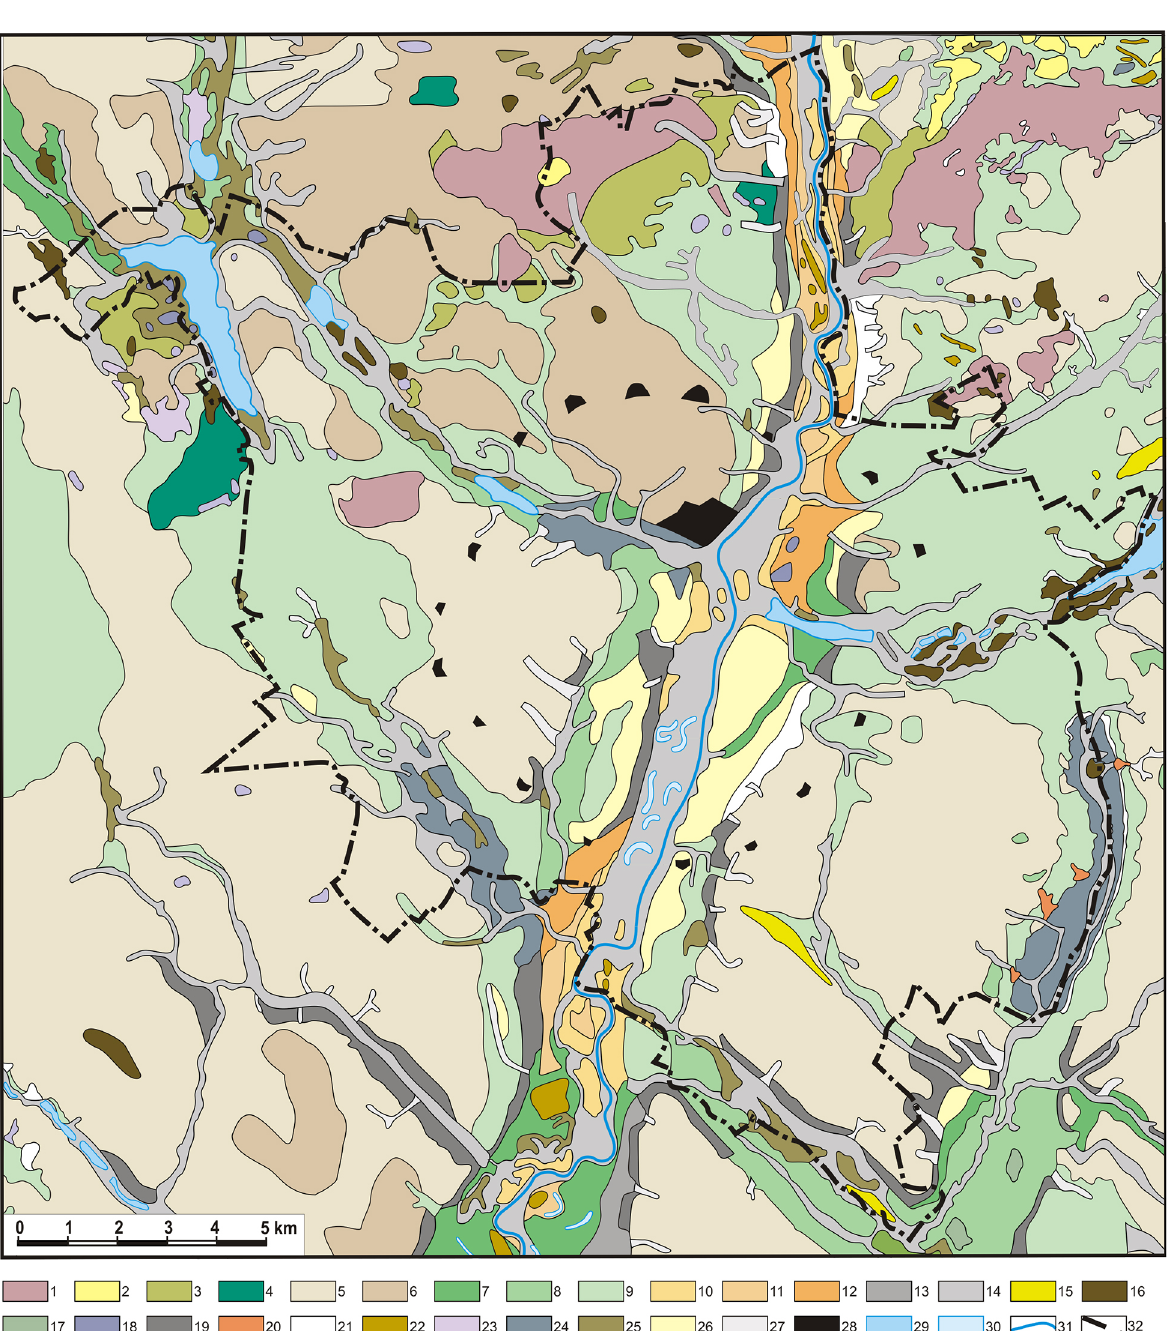
Fig. 2. Geomorphological map of Poznan area (Hildebrandt-Radke 2016, elaborated on the basis of previous geomorphological maps acc. Bartkowski 1957, Tomaszewski 1960, krygowski 1961, and geomorphological sketches attached to the detailed Geological Map of Poland by Chmal 1992, 1996, 1997, Bartczak 1993, Gogołek 1993, Chachaj 1996, Cincio 1996, Sydow 1996;